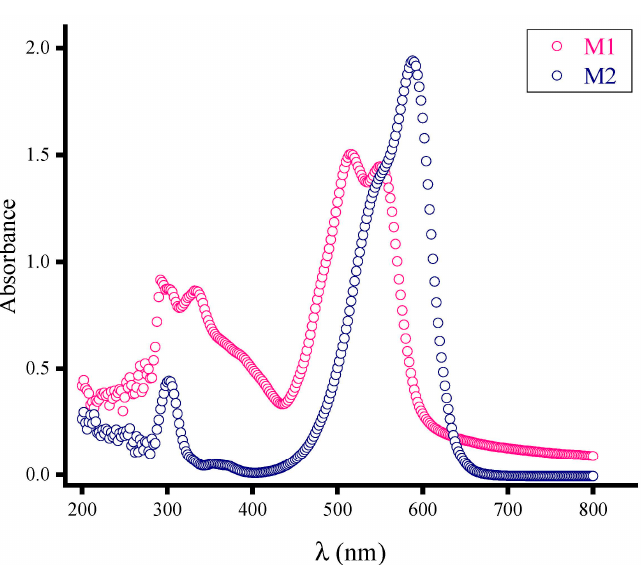
Figure 7. The UV-Vis spectra of M1 and M2 in aqueous solution (10 mg/100 mL) at pH = 7.